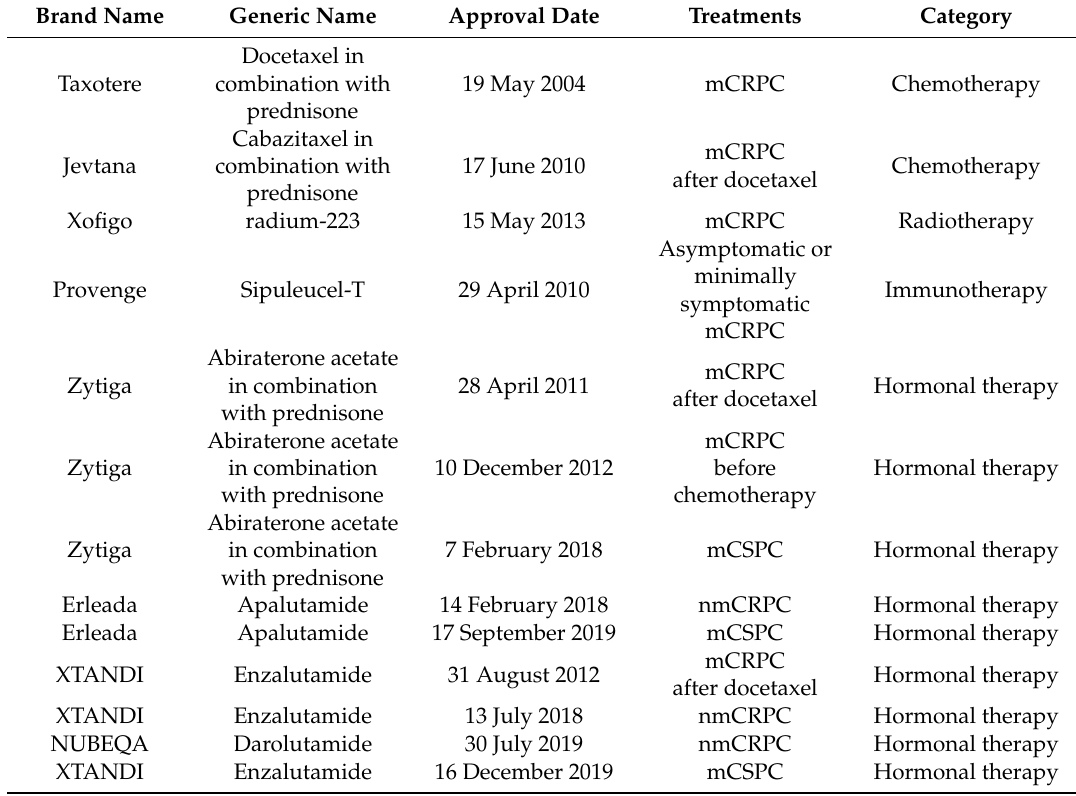
Table 1. Current Treatments with Survival Benefit for Patients with Prostate